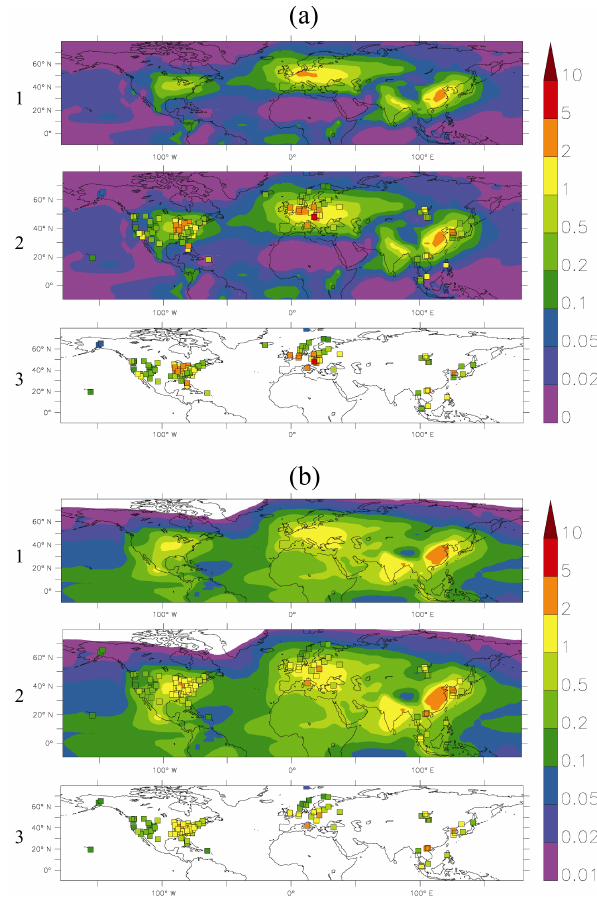
Figure 13. Comparison of 3-D CTM modelling results obtained with HyDiS-1.0 in the hybrid configuration (1) against observa- tions (3), also compared directly on top of each other (2), for total aerosol nitrate (a) and ammonium (b) at ground level, all in µgm − 3 and annually averaged for the year